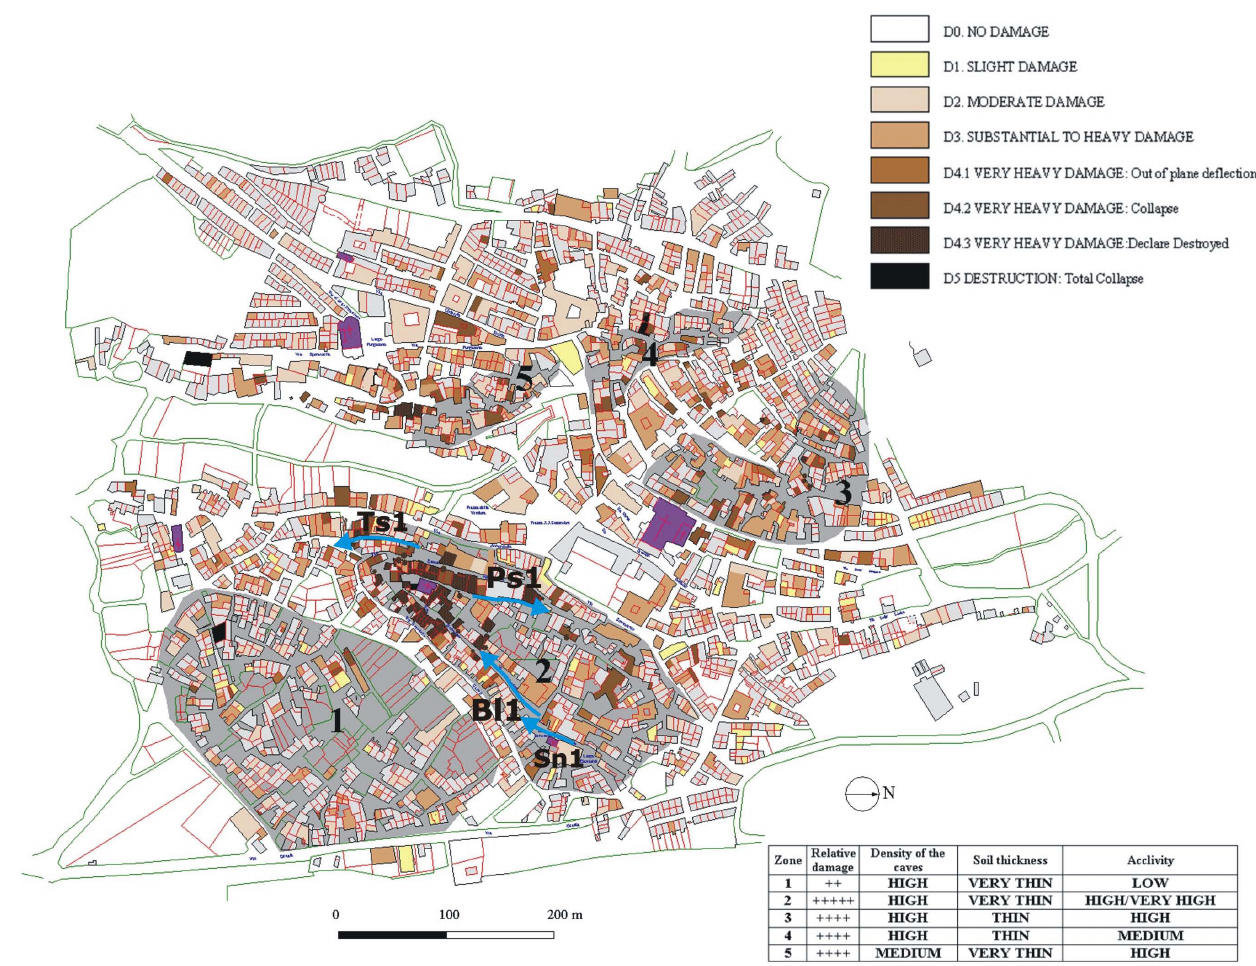
Fig. 2. Damage “scenario” for Rionero in Vulture as delineated by the analysis of historical sources (degree of damage is given in EMS-98 scale, Grunthal, 1998). The figure also shows the areas in which the caves are localized. At the bottom right-corner a table reports some features of these areas that seem suggest a key role in producing a local increase of damage. Profiles of georadar investigations are also indicated (Ts1=Trieste street; Ps1= Pisacane street; Bl1= Belvedere street; Sn1=San Nicola street).